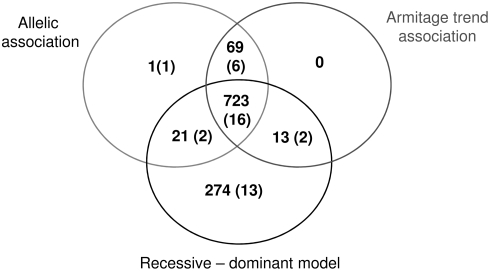
Selection and Verification of SNPs And Haplotypes from the GWAS Analysis.GWAS SNPs and haplotypes were ranked by P-value and the top 1101 (of 14,065 total associated) SNPs and 35 (of 3,549 non-overlapping total associated) haplotypes were carried through to the follow-up stage. Numbers in parenthesis indicate the number of variants selected from the GWAS by each method of selection that were subsequently replicated in the family-based study.